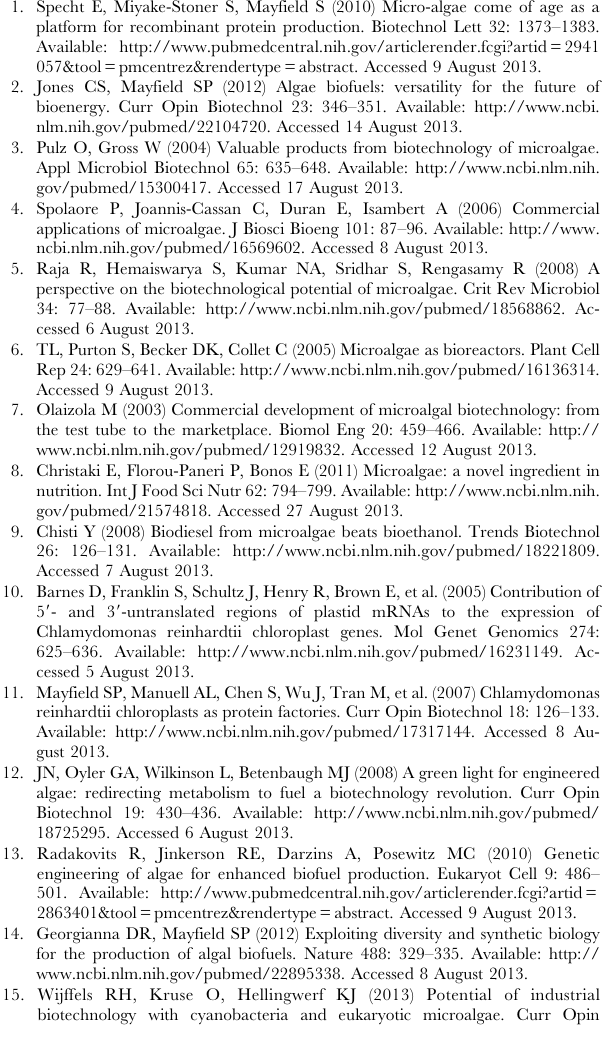
Table S1 Oligonucleotides used in this study to construct Chlamydomonas targeting